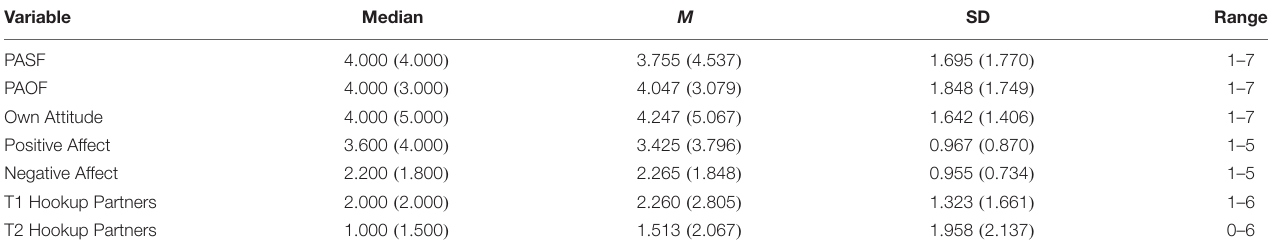
TABLE 1 | Sample characteristics ( N = 314).